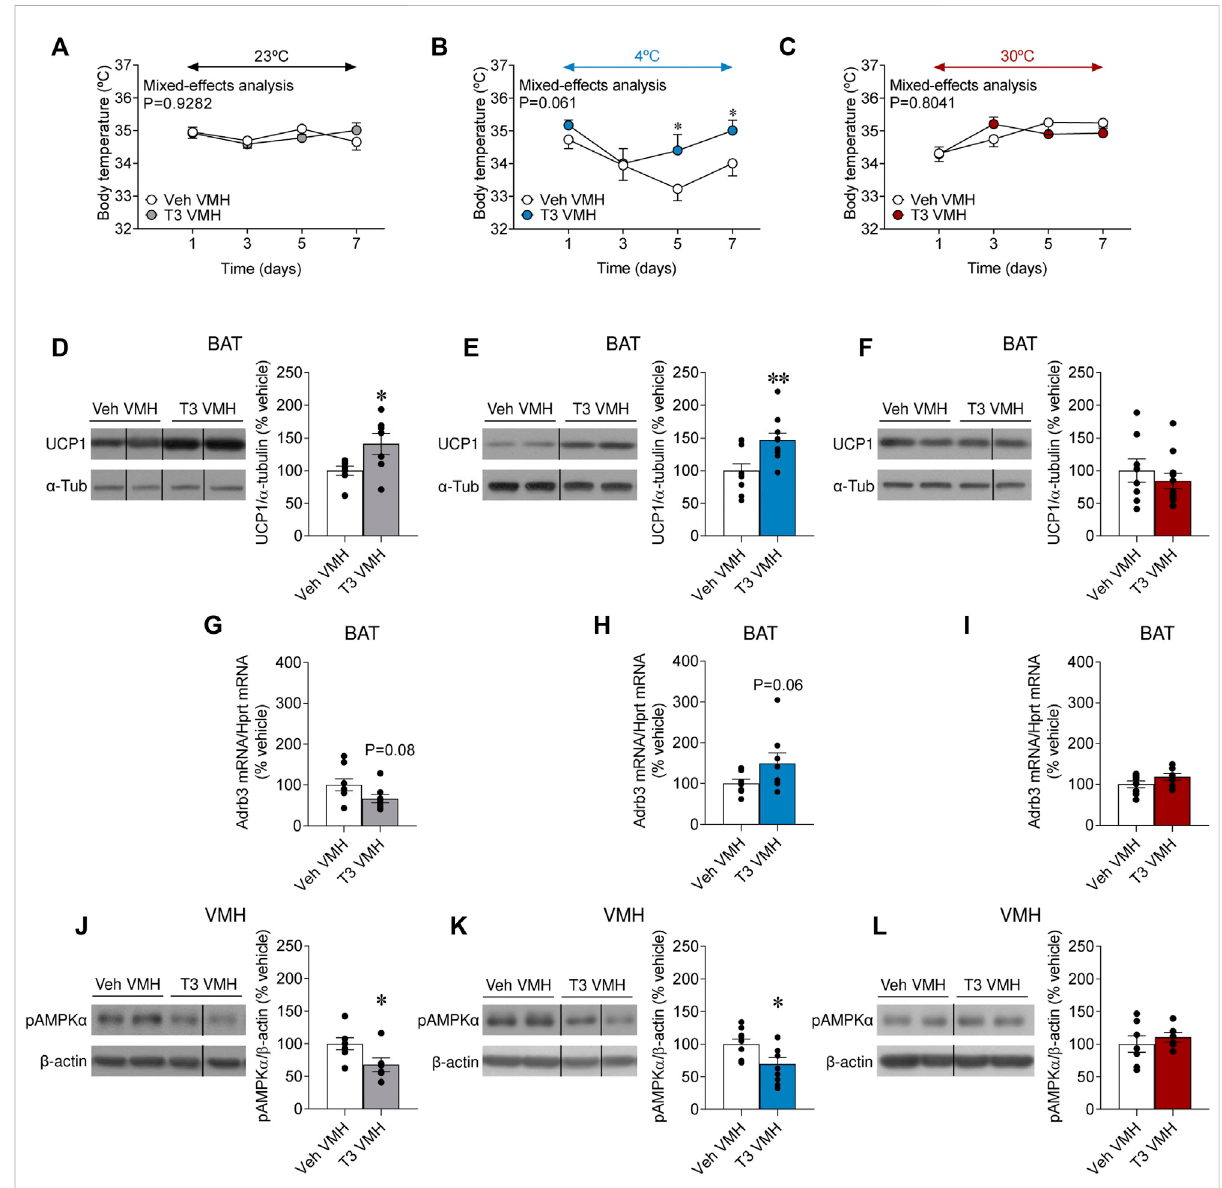
FIGURE 5 Effects of temperature on BAT thermogenesis and hypothalamic AMPK in rats centrally treated with T3 (A – C) Body weight change, (D – F) UCP1 protein levels in BAT, (G – I) Adrb3 mRNA levels in BAT, and (J – L) pAMPK α protein levels in the VMH of rats stereotaxically treated with the vehicle of T3 housed at 23 ° C (A,D,G,J) , 4 ° C (B,E,H,K) or 30 ° C (C,F,I,L) . Data are represented as MEAN ± SEM. n = 6 – 11 rats/group. Statistical signi fi cance was determined by Mixed effect analysis or Student ’ s t-test * p < 0.05, ** p < 0.01 vs. vehicle